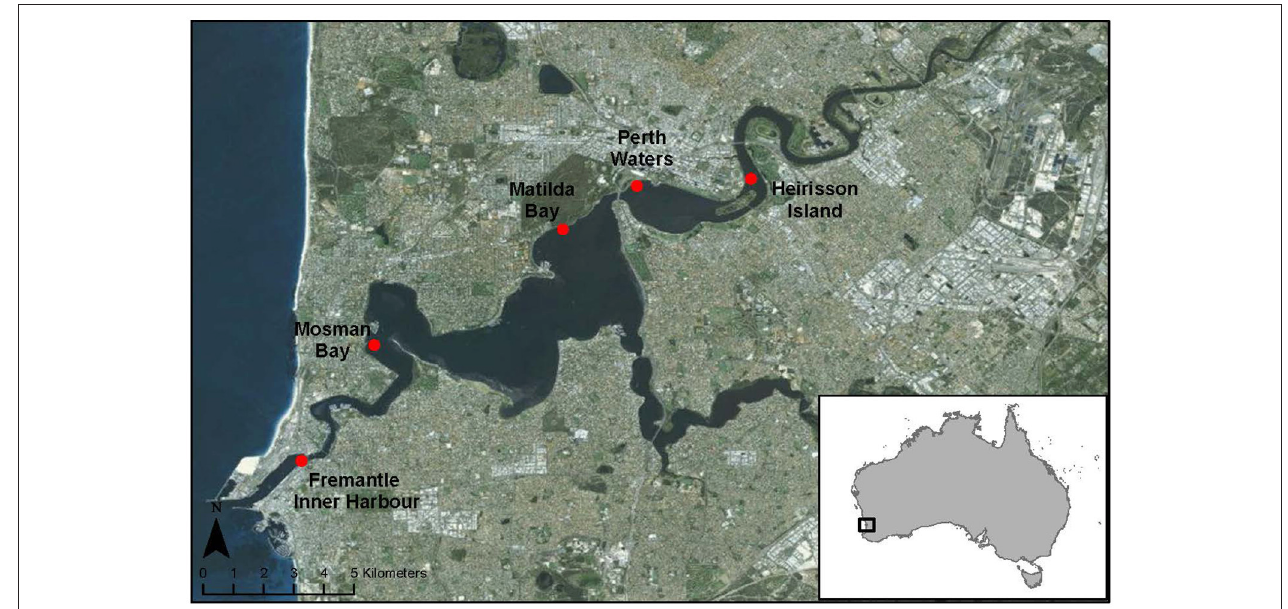
FIGURE 1 | Map of the Swan River with the five acoustic monitoring sites